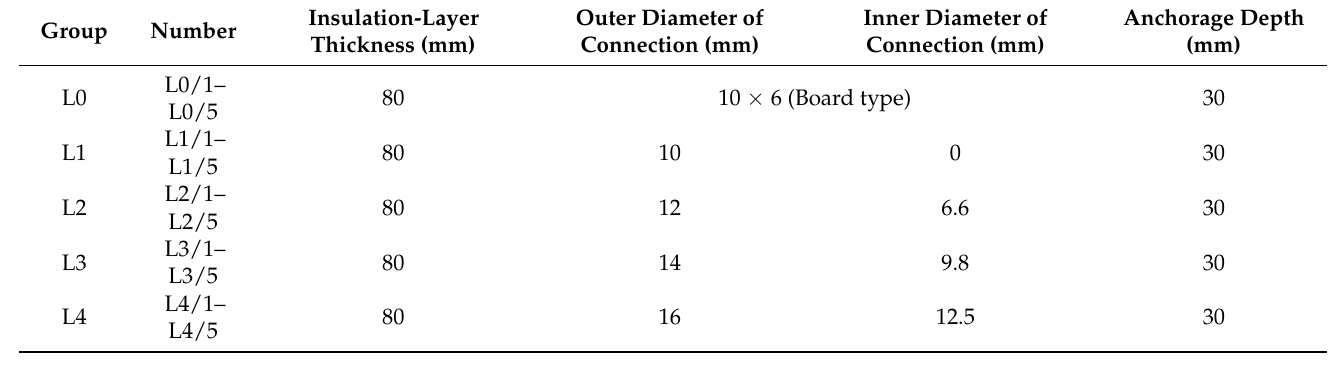
Table 4. Shear test specimen parameters.